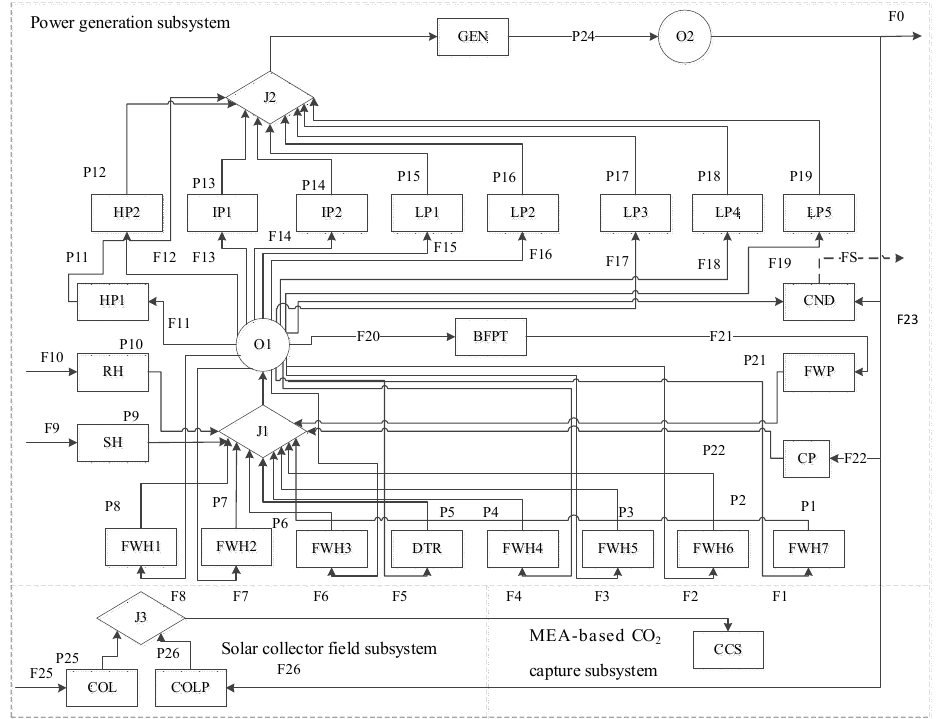
Figure 7. Productive structure of the solar-aided CO 2 capture coal-fired power generation (SA-CC- PG) system.